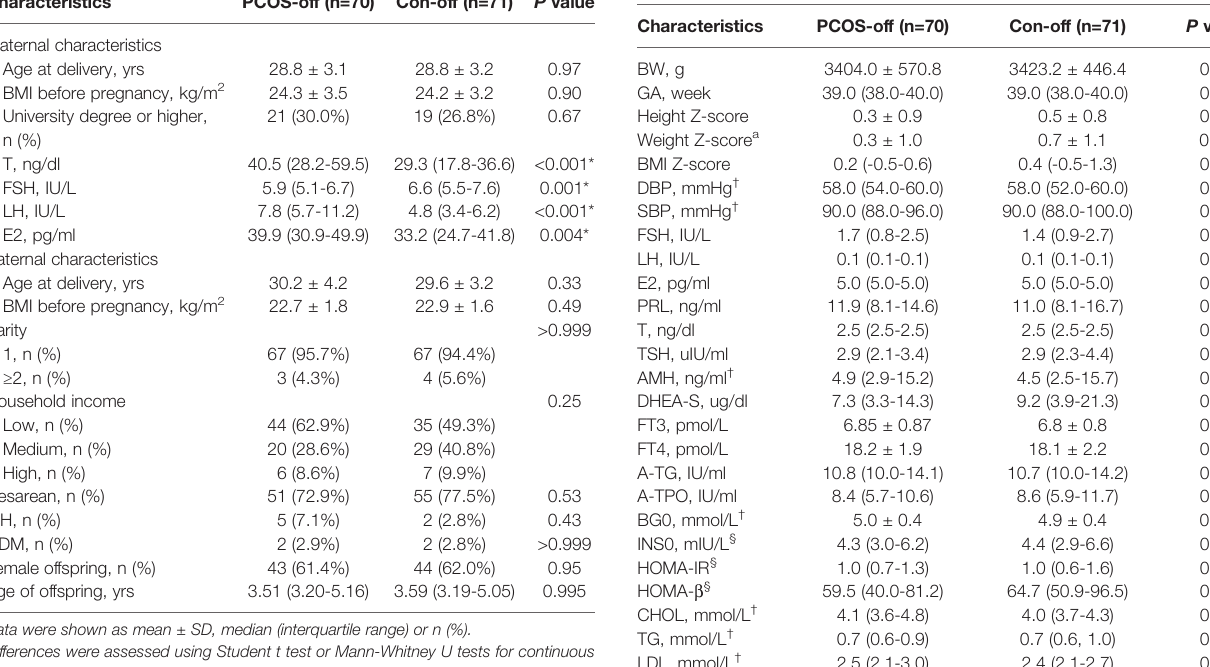
TABLE 2 | Clinical characteristics of the general offspring born to women with or without PCOS.